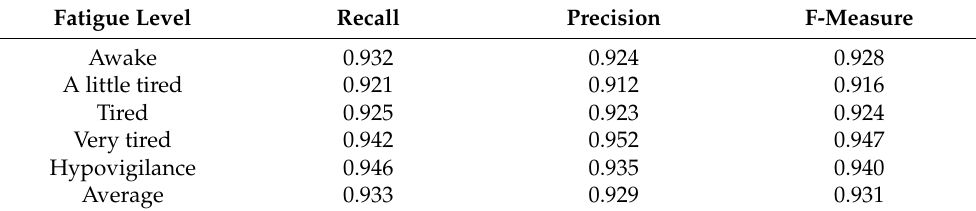
Table 3. Evaluation of the HyMobLSTM model for fine-tuned experiment.